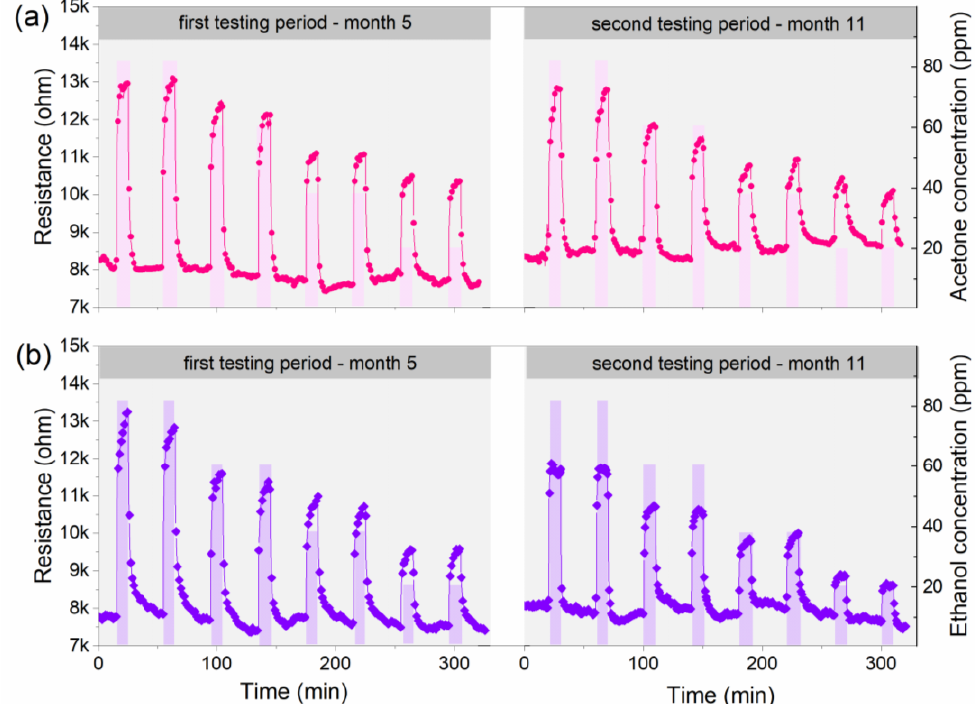
Figure 7. Comparison of the resistance changes for the samples annealed at 450 °C toward various concentrations of ( a ) acetone and ( b ) ethanol measured at 285 °C during the first and second testing periods. The resistance is represented by a line with symbols, whereas the concentrations are displayed as pink and purple bars for acetone and ethanol, respectively.